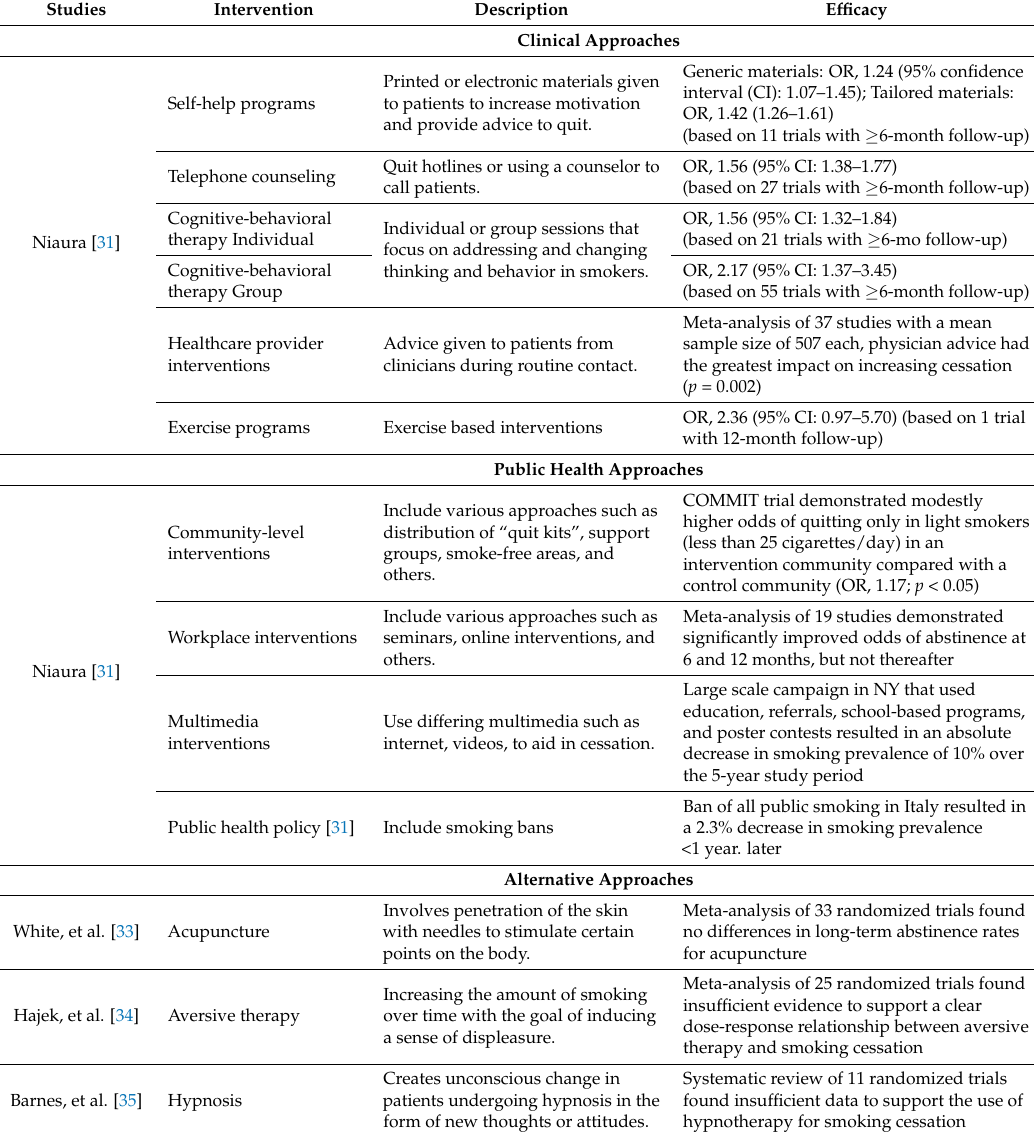
Table 5. Non-pharmacologic interventions for smoking cessation